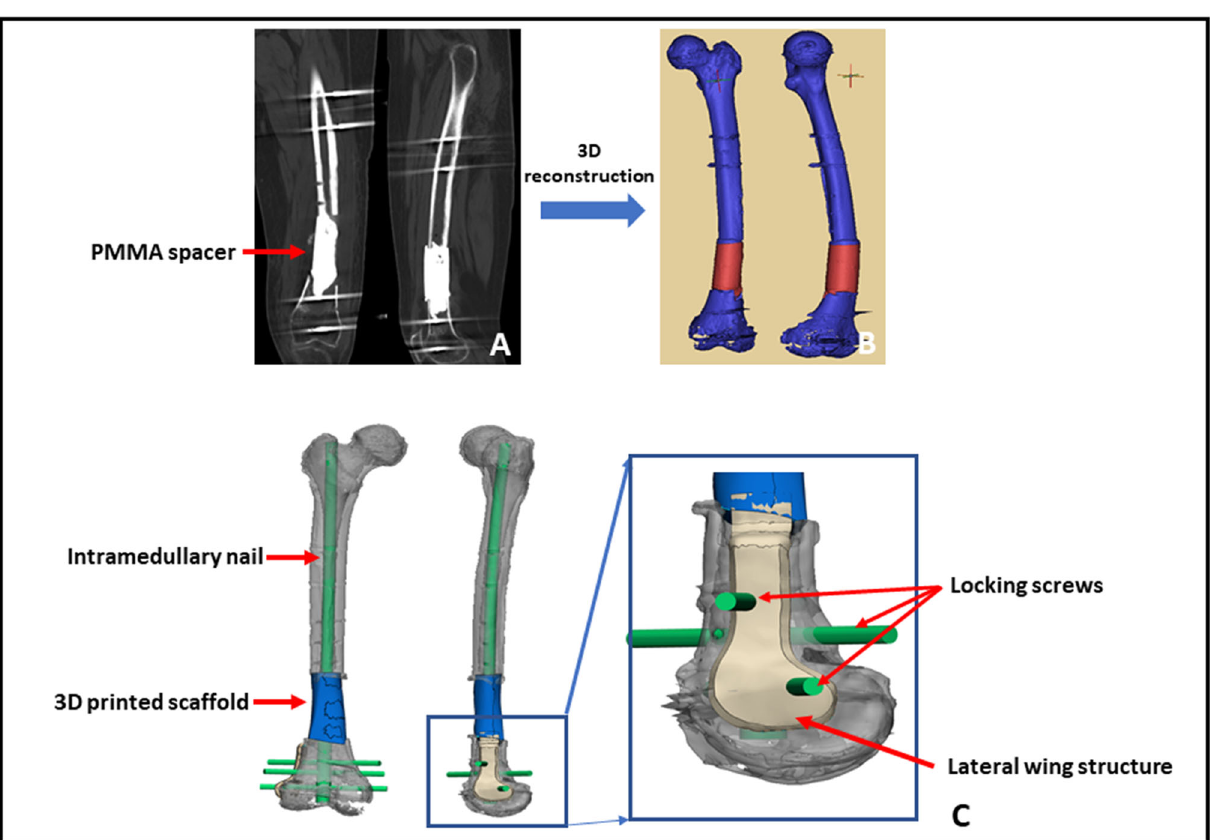
Fig. 1 The design process of 3D porous scaffold. A CT scan images of the femoral shaft with PMMA spacer; B 3D reconstruction was per- formed based upon CT scan; C the suitable scaffold model design and